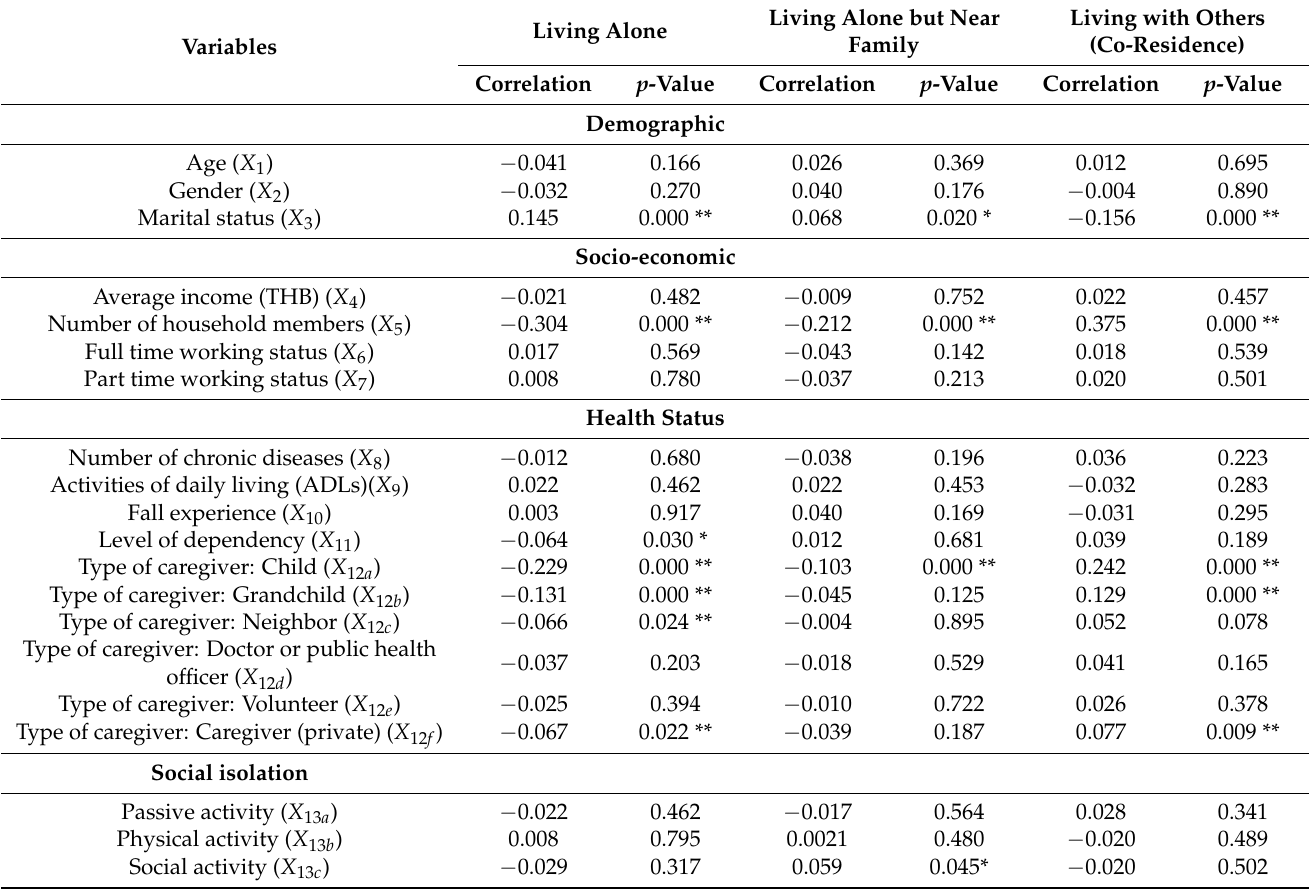
Table 5. Correlation of living alone with characteristics of older adults (demographic, socio-economic, health status, and social